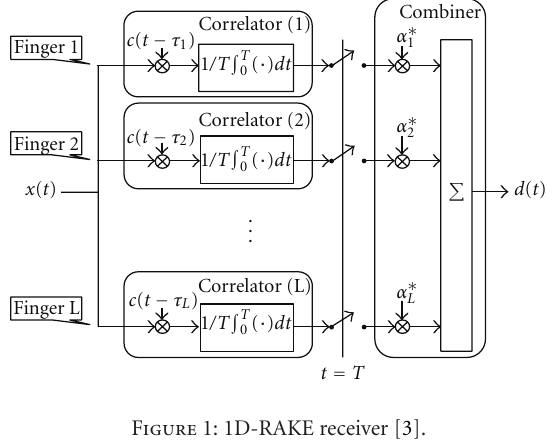
Figure 1: 1D-RAKE receiver [3].